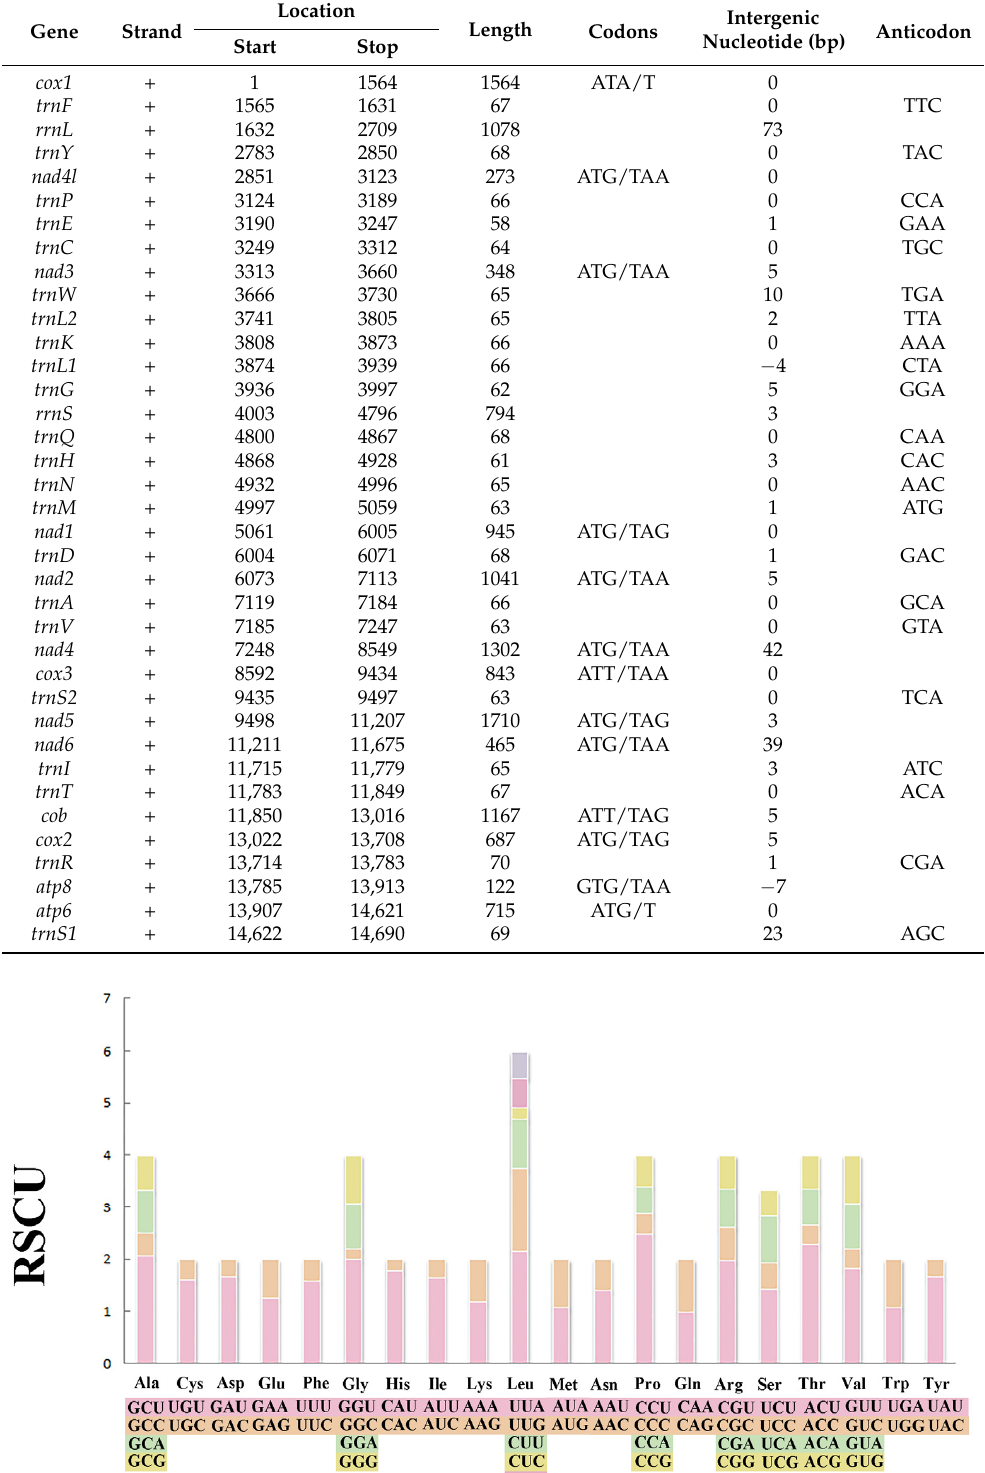
Table 2. Annotation of the M. virgata mitochondrial genome.